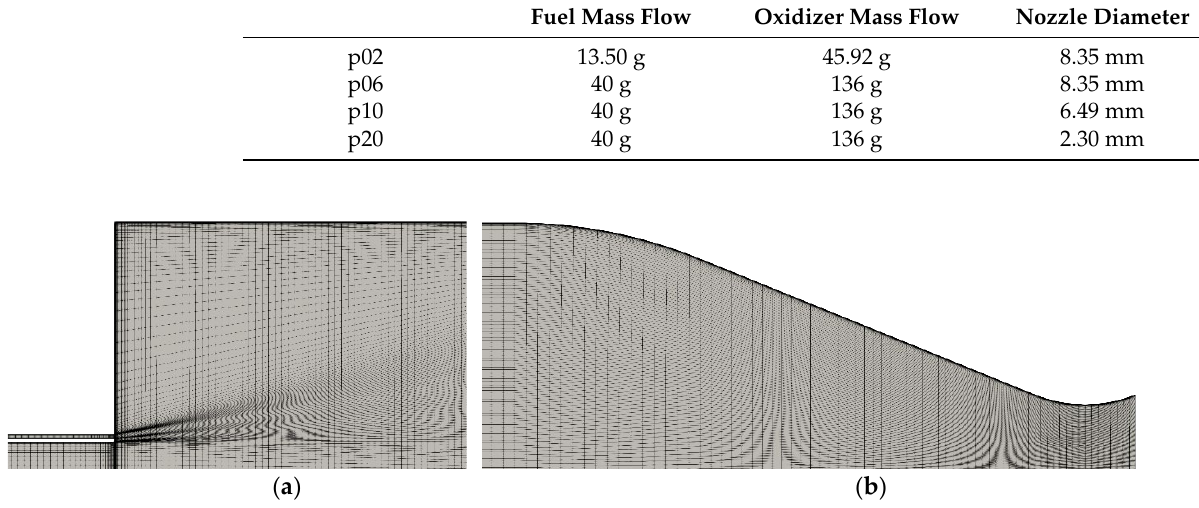
Table 9. Mass flow and nozzle diameters for the different setups in the CFD simulations.